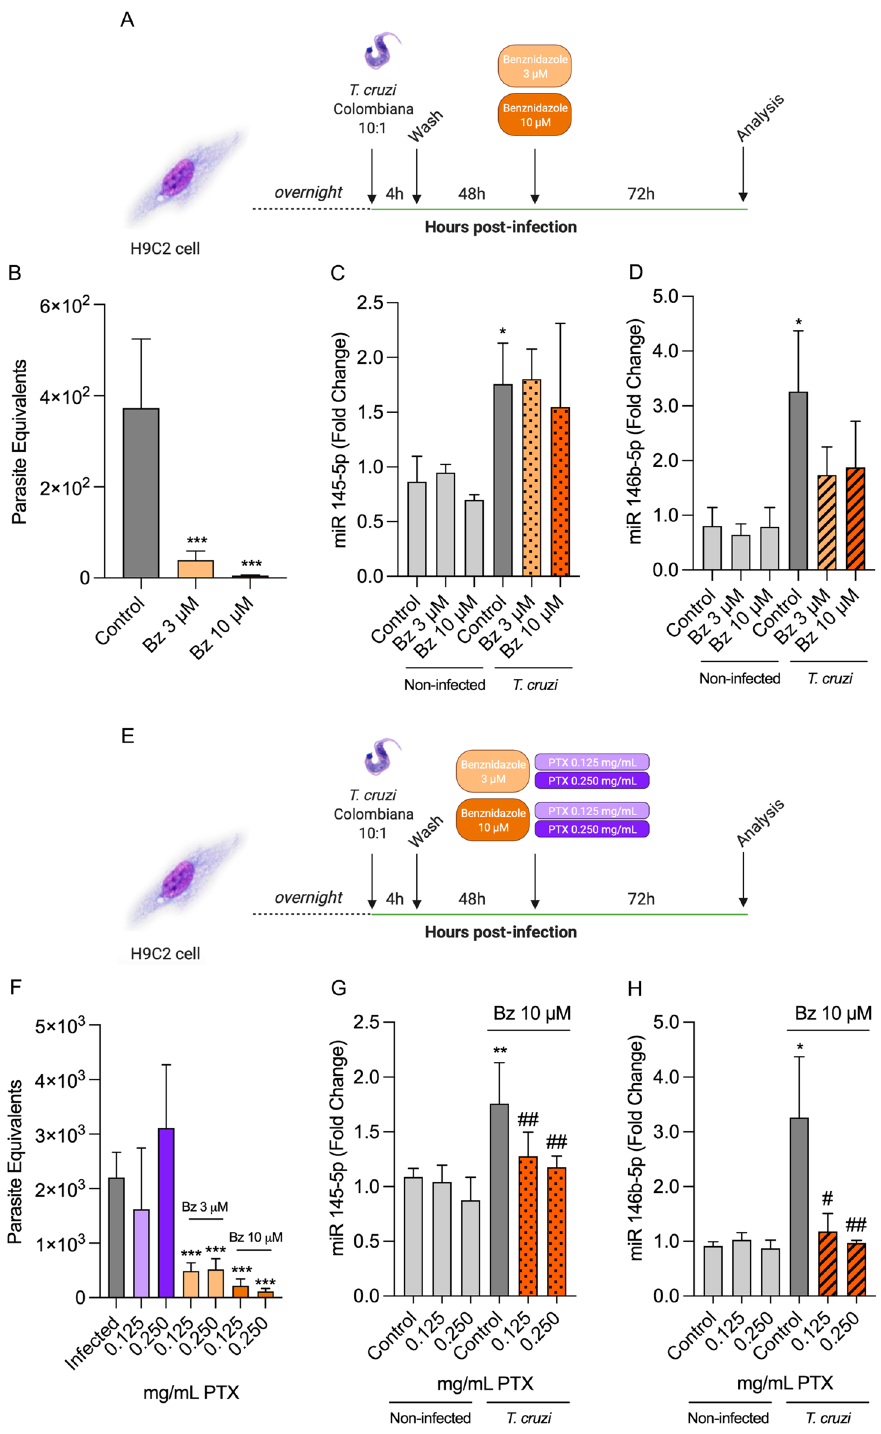
Figure 3. Combined therapy with Benznidazole and Pentoxifylline reverse miR-145-5p and miR-146b-5p upregulation. ( A ) H9C2 cells were infected with 10:1 T. cruzi trypomastigotes for 4 h, washed, treated 48 h post-infection with 3 µM and 5 µM of Bz and collected 72 h later. ( B ) Parasite load of H9C2 cells infected with T. cruzi and treated with 3 µM and 5 µM of Bz. ( C ) miR-145-5p gene expression, ( D ) miR-146b-5p gene expression, ( E ) H9C2 cells were infected with 10:1 T. cruzi trypomastigotes for 4 h, washed, treated 48 h post- infection with 3 µM and 5 µM of Bz + PTX 0.125 mg/mL and 0.250 mg/mL and collected 72 h later. ( F ) Parasite load of H9C2 cells infected with T. cruzi and treated with Bz + PTX. ( G ) miR-145-5p levels, ( H ) miR-145-5p levels. For all graphs, significance was determined using unpaired Student’s t test or Mann–Whitney Rank Sum (*p < 0.05, **p < 0.01, ***p < 0.001. The experiment was repeated three times, using different cell culture flasks in each experimental